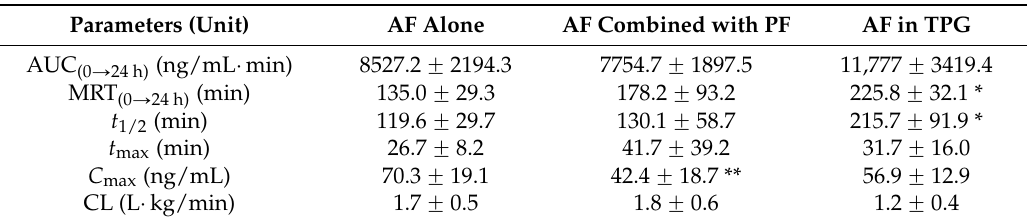
Figure 4. The mean plasma concentration–time profiles of albiflorin (AF) in rat plasma. AF was administered orally to rats in the alone, AF combined with paeoniflorin, and AF in TPG groups. The values are the mean ± SD, n = 6. Table 3. The main pharmacokinetic parameters of AF with three different forms in rat plasma after intragastric administration ( n = 6).